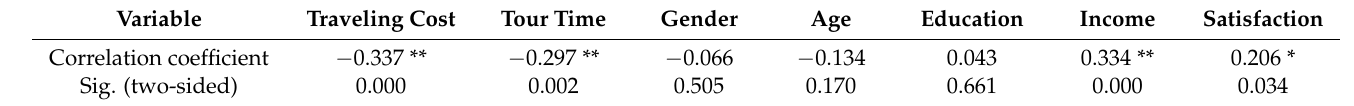
Table 4. Analysis of the correlation between the number of trips to Dachangshan Island and other factors.